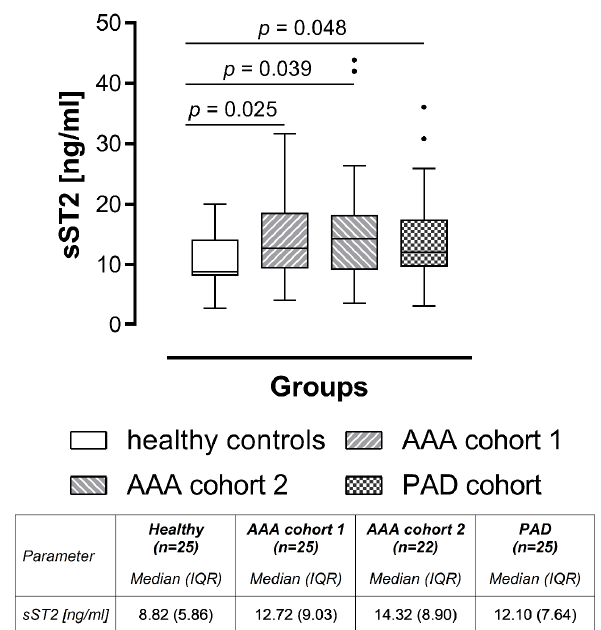
Figure 1. Comparison of circulating sST2 concentrations between AAA patients and control groups. For the diagnostic study, circulating sST2 concentrations were measured in serum samples from 25 healthy controls, matched one-to-one (age, sex, best possible in smoking habit) with 25 AAA cohort 1 patients, 22 AAA cohort 2 patients and 25 PAD patients (additionally matched for previous cardiovascular disease). Statistical analysis was performed by using a Wilcoxon signed rank test, and the boxplot illustrates the sST2 values according to Tukey’s style. Abbreviations: sST2, soluble suppression of tumorigenesis 2; AAA, abdominal aortic aneurysm; PAD, peripheral artery disease; n , number of individuals; IQR, interquartile range.